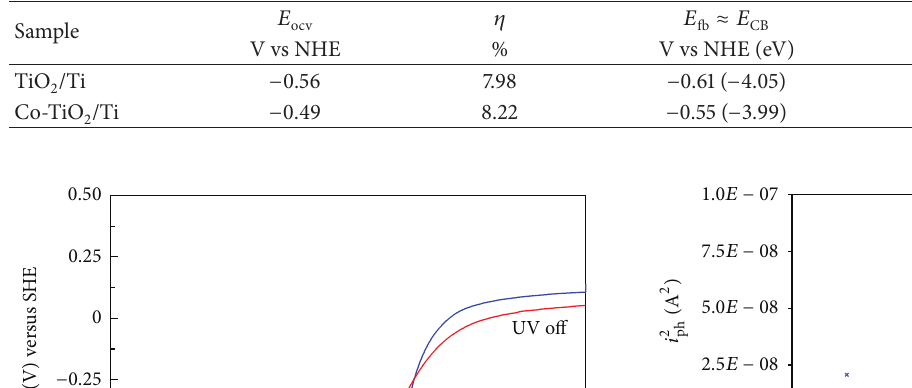
/Ti and Co-TiO /Ti anodes. 2 2